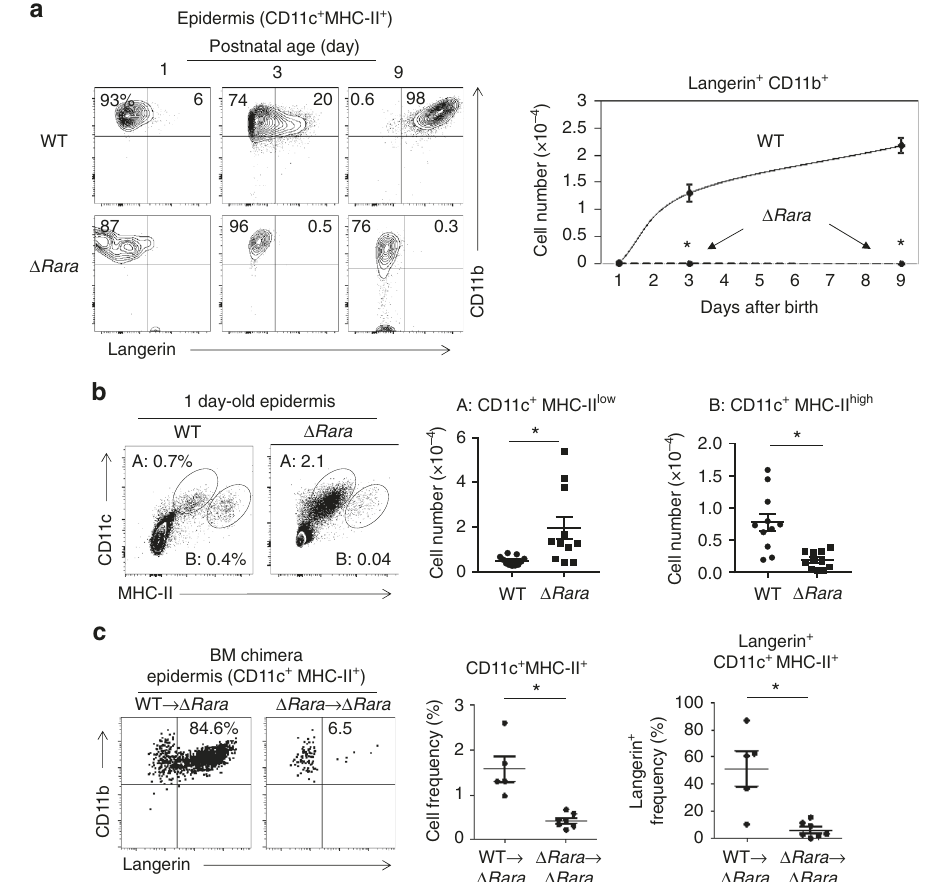
Fig. 2 LC development in newborn mice and following BM transfer requires RAR α . a Kinetics of langerin up-regulation on CD11c + MHC-II + cells in the epidermis of WT and Δ Rara CD11c mice determined at postnatal day 1, 3, and 9. b Phenotype of epidermal DCs in new born (1-day old) mice. Trunk skin of WT and Δ Rara CD11c mice was examined for CD11c + MHC-II + cells. c A BM reconstitution study from WT or Δ Rara CD11c mice into lethally irradiated Δ Rara CD11c mice. As WT control mice, we used either C57BL/6 or CD11C-Cre-GFP mice. The frequency of total CD11c + MHC-II + cells and epidermal langerin + cells (% of CD11c + MHC-II + ) were examined 12 – 15 weeks post-BM transfer. Representative and combined data ( n = 4 – 8) from at least